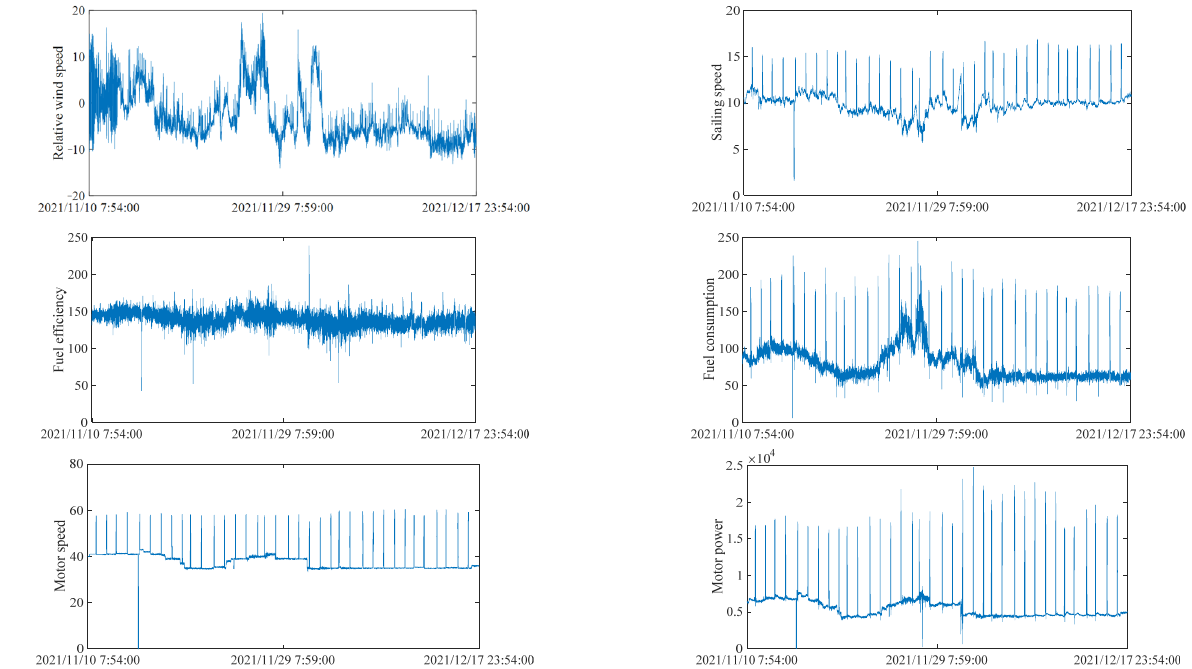
Figure 9. Real data collected by the experimental equipment for encryption.